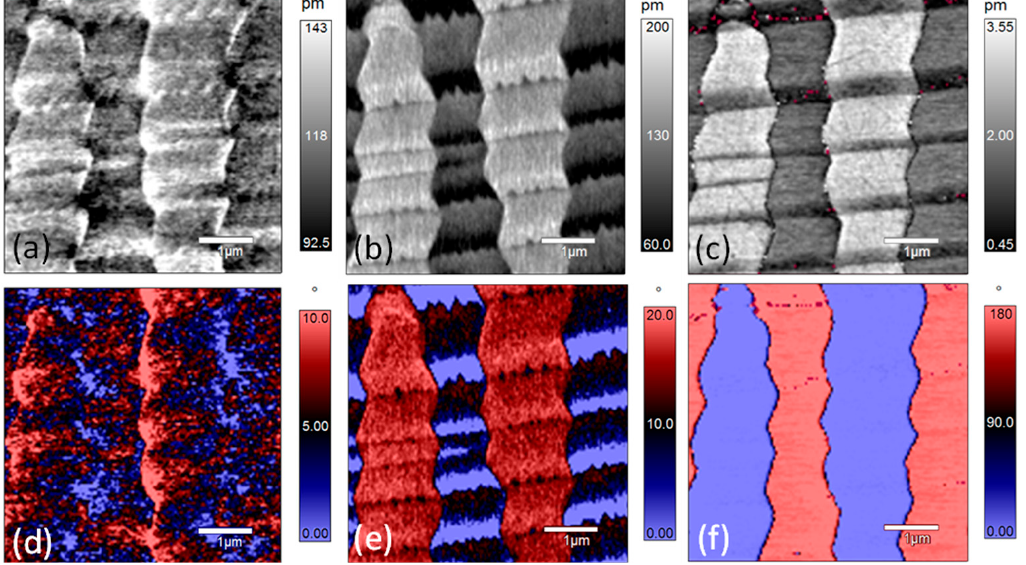
Figure 6. PFM amplitude and phase of [001]-cut PZN-7%PT single crystal at 120 ◦ C: ( a – c ) amplitude images of x-LPFM, y-LPFM, and VPFM, respectively; and ( d – f ) phase images of x-LPFM, y-LPFM, and VPFM, respectively.